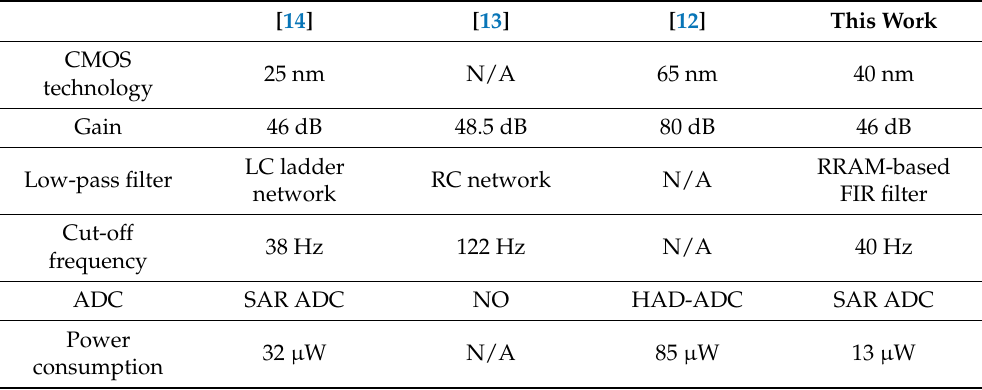
Table 1. Performance comparison with the published